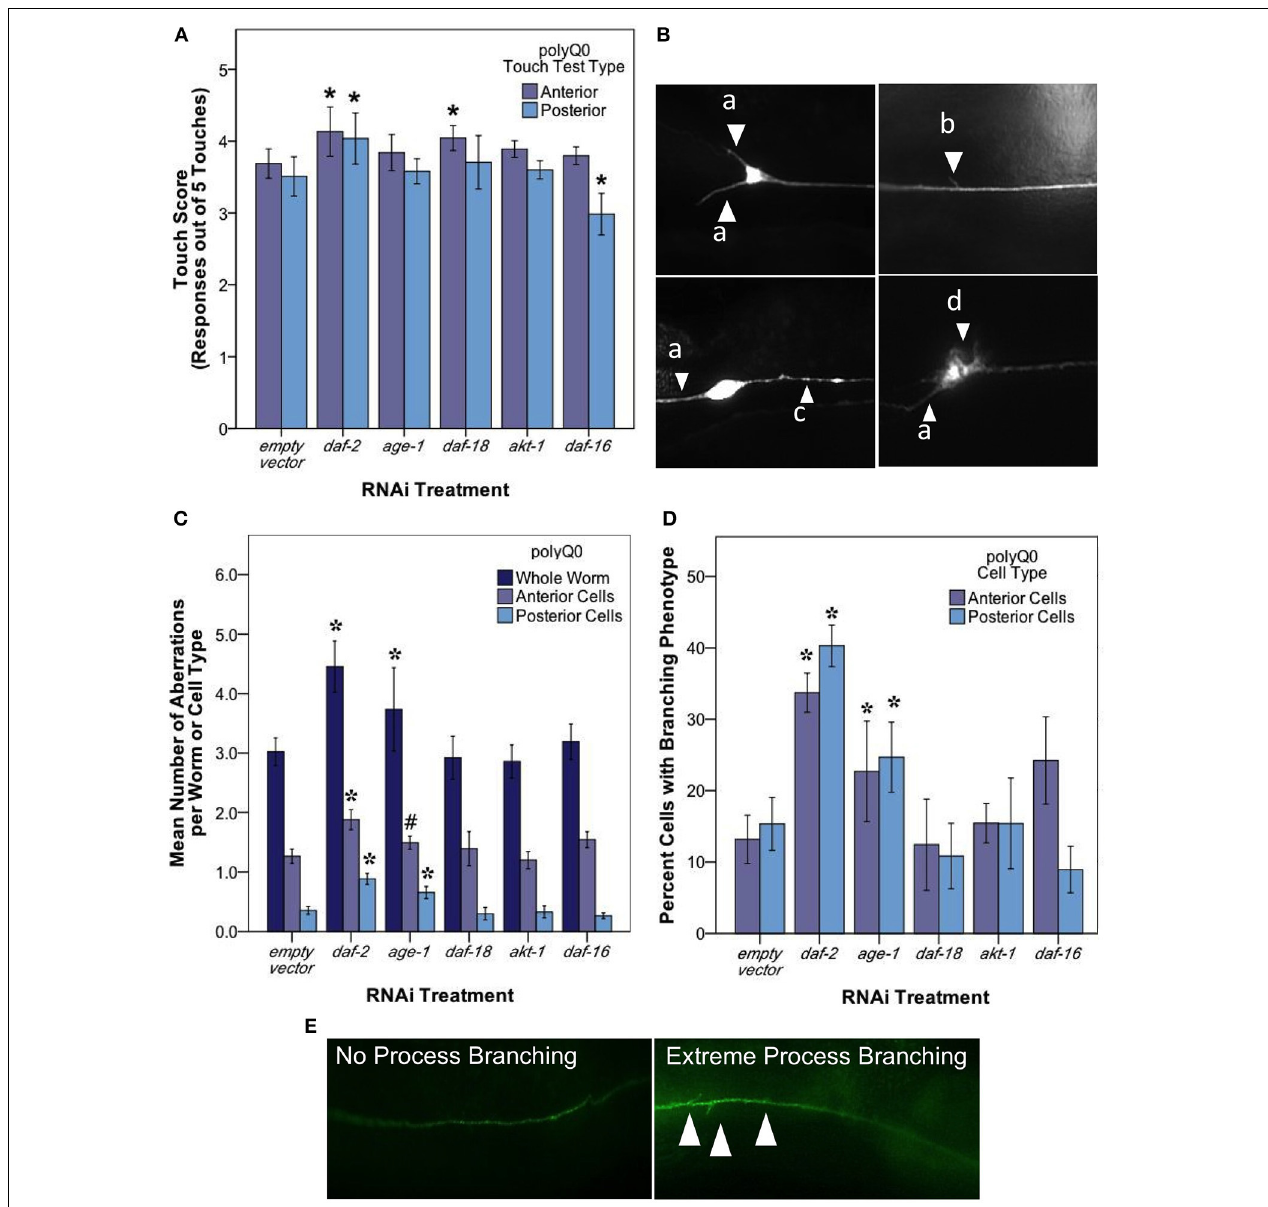
FIGURE 4 | daf-2 RNAi mediates mechanosensory neuron morphology and function in polyQ0 animals. (A) Anterior and posterior touch test scores of polyQ0 animals following RNAi treatment. Each bar represents the mean number of positive responses to 5 soft touches. (B) Representative examples of outgrowths (a), branching (b), punctae (c), and abnormal cell body (d) phenotypes seen in aging mechanosensory neurons of polyQ0 and polyQ128 individuals. (C) Mean number of neuronal aberrations per whole animal (sum of all 4 neurons scored in an individual) and individual cell type (anterior [ALML or ALMR] and posterior [PLML or